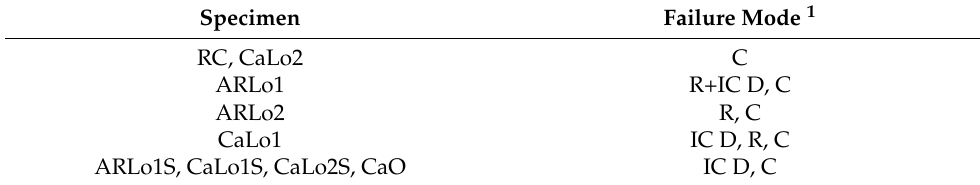
Table 5. Summary of failure modes.